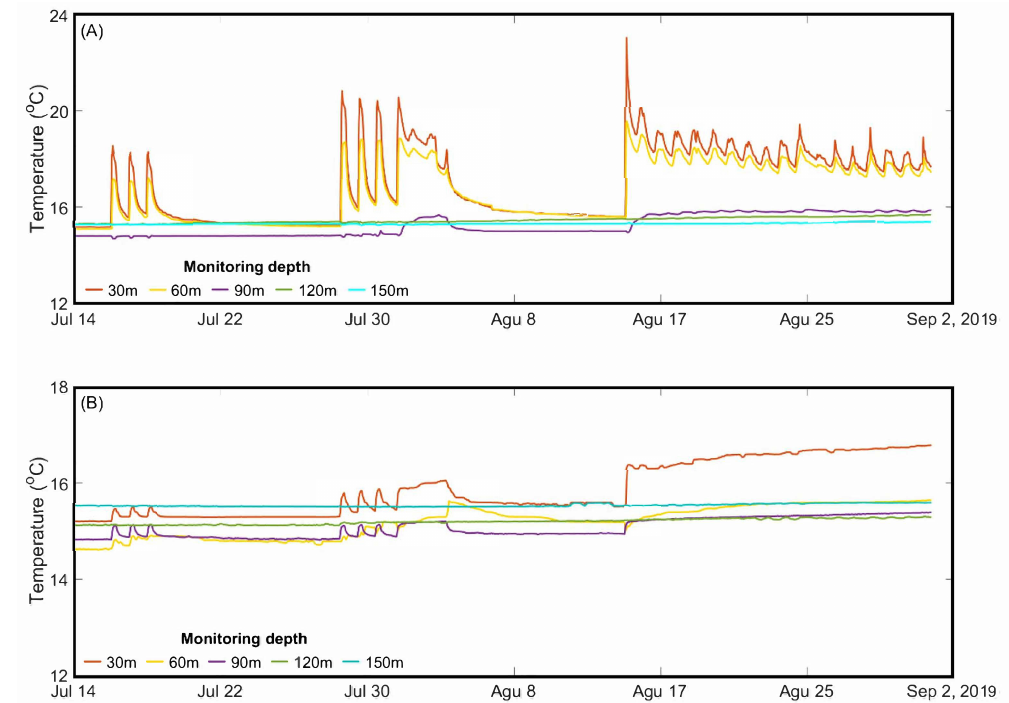
Figure 3. Temperature variation with depth at injection ( A ) and observation ( B ) wells from 14 July to 2 September